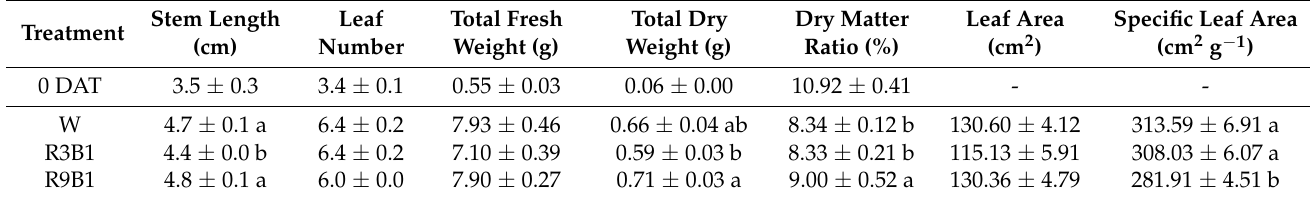
Table 6. Effect of light quality on the growth of ‘Micro-Tom’ 10 DAT in Experiment 2. Each value represents the mean ± standard error. Different letters in a column indicate significant differences among the treatments based on Tukey − Kramer’s test at p < 0.05 ( n = 9). W: white light; R3B1: red/blue ratio = 3; R9B1: red/blue ratio = 9.